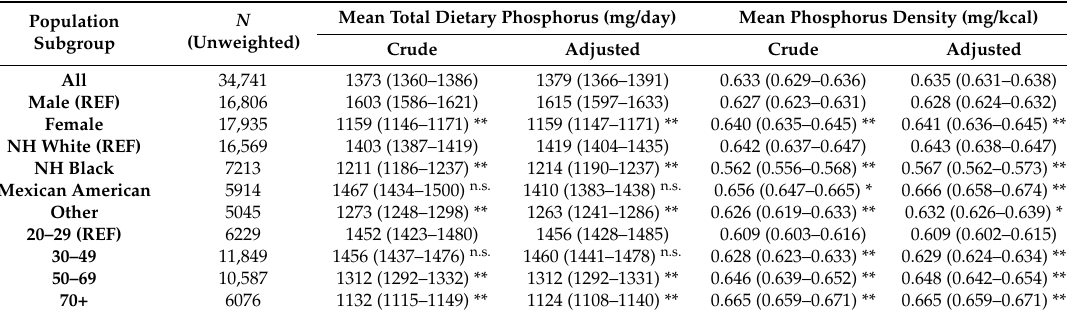
Table 2. Crude and age-adjusted estimated means (95% CIs) for total dietary phosphorus and phosphorus density for adults 20 years of age or older, NHANES WWEIA 2001–2014.